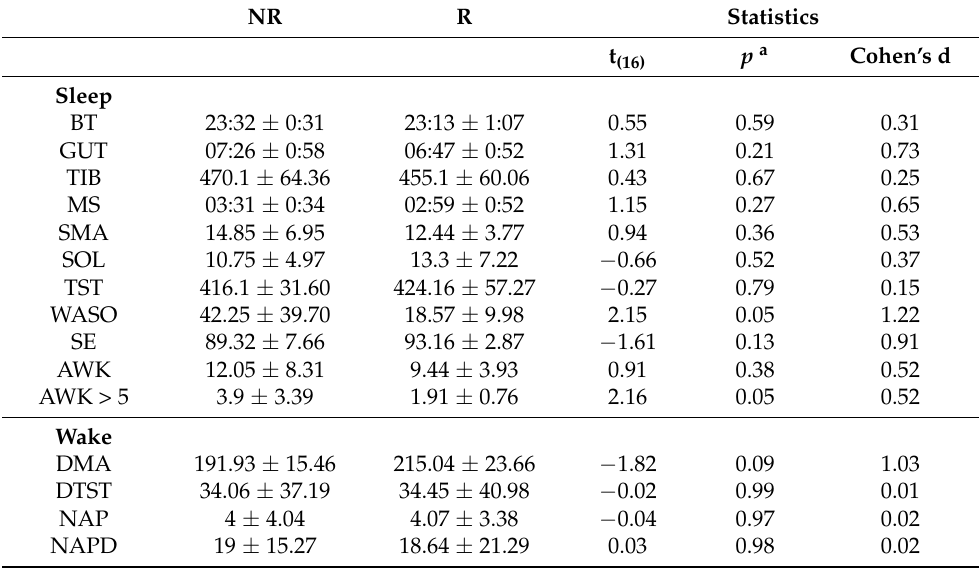
Table 1. Means and standard deviations of actigraphic sleep/wake measures, measured at T0, in the non-responder (NR) group and responder (R) group. NR R Statistics p a Cohen’s